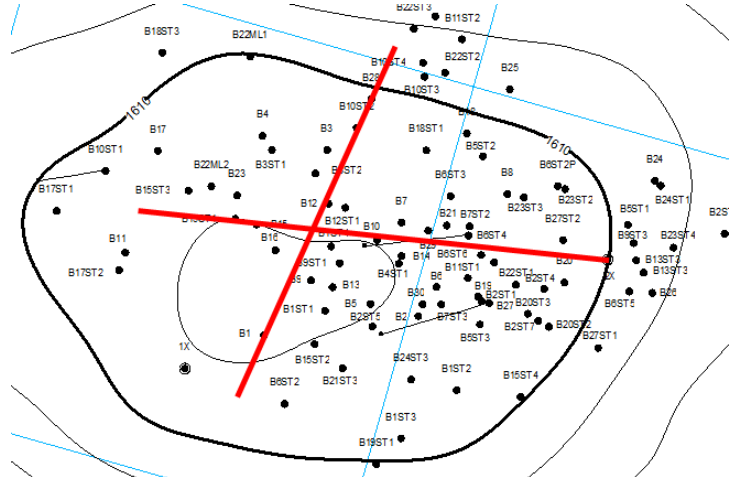
Fig. 1 Well location map of the study area.